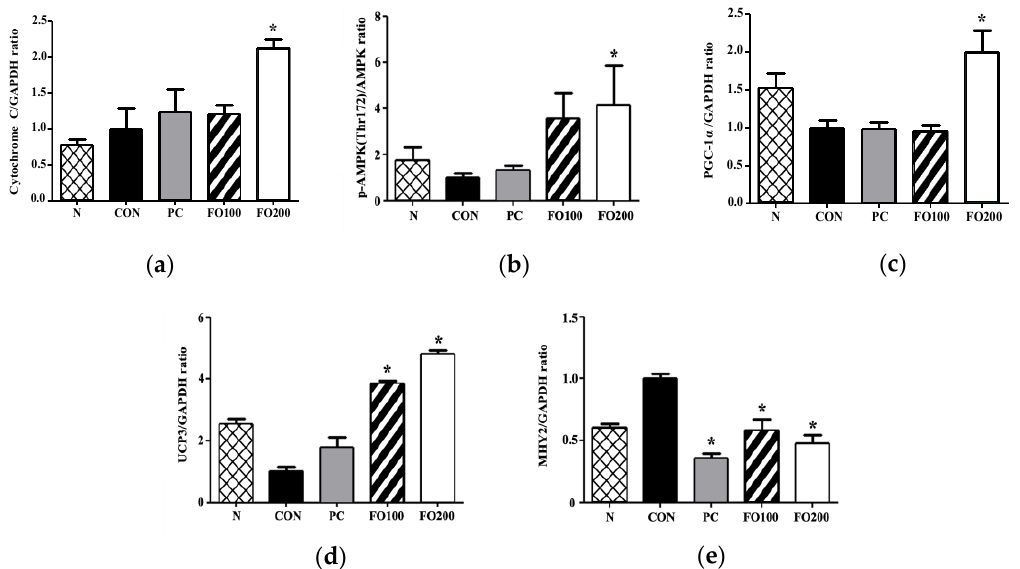
Figure 11. Immunohistochemical analysis of ( a ) cytochrome C, ( b ) p-AMPK (Thr172), ( c ) PGC-1a, ( d ) UCP3 and ( e ) MYH2 was carried out to measure changes following administration of 100 and 200 μg/mL of FO. Each bar represents the mean ± SD. A one-way ANOVA test was carried out to determine significant differences (* p < 0.05 vs. Control).